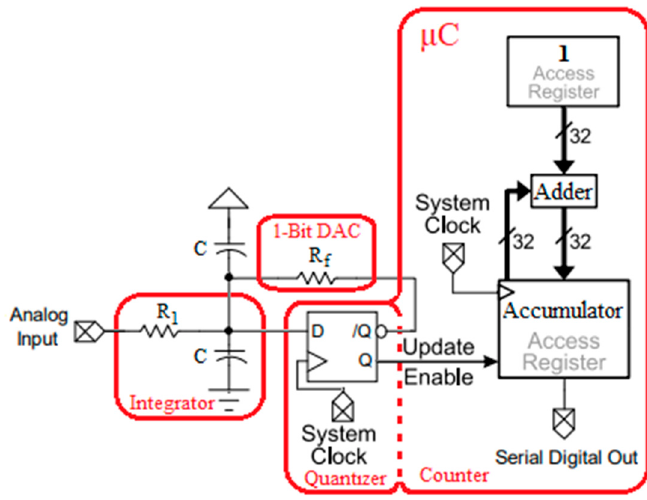
Figure 11. Σ∆ -ADC hardware implementation. Figure 11. ΣΔ -ADC hardware implementation. Figure 11. ΣΔ -ADC hardware implementation.